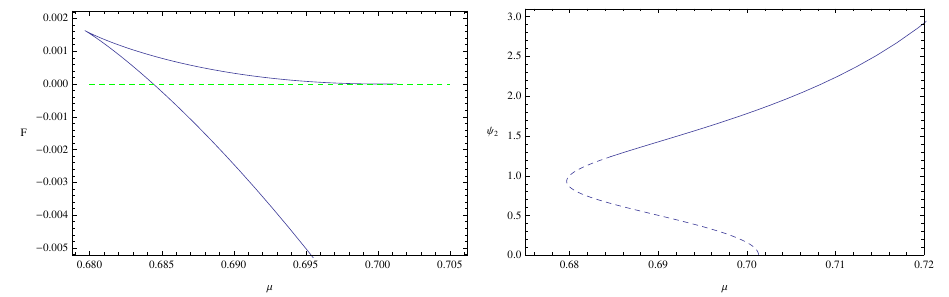
Figure 4 . (Color online) We show phases with q = 4, m 2 = − 2 and C 4 = 0. In the left panel, we plot the free energy of boson star as a function of the chemical potential with solid blue curves and the dashed green curves of F = 0 is with the flat space. The solid blue line in the right panel represents behaviors of parameter ψ 2 in the thermodynamically stable phases and the dashed blue line in the right panel are with thermodynamically unstable